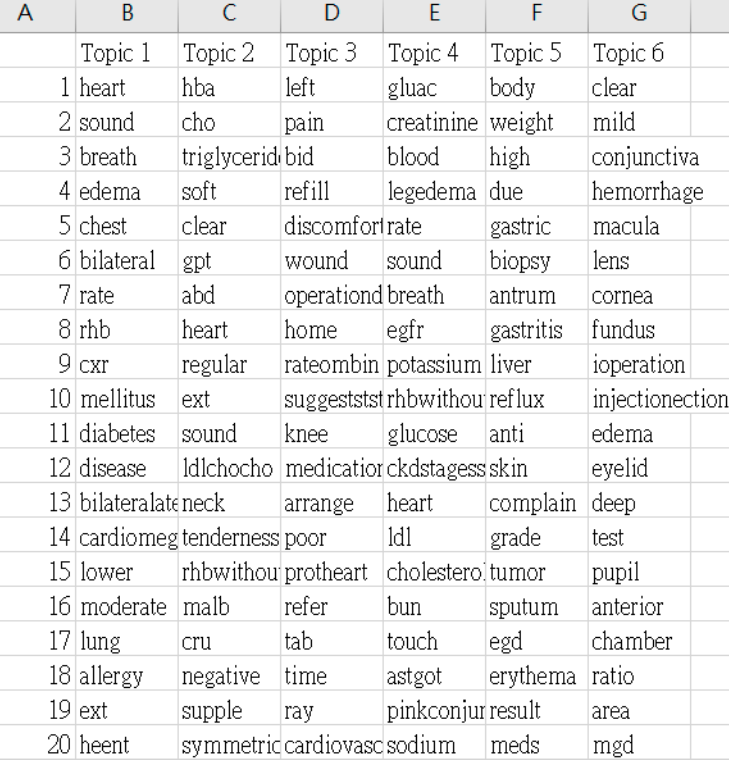
Figure 9. List of words for each topic (E11).